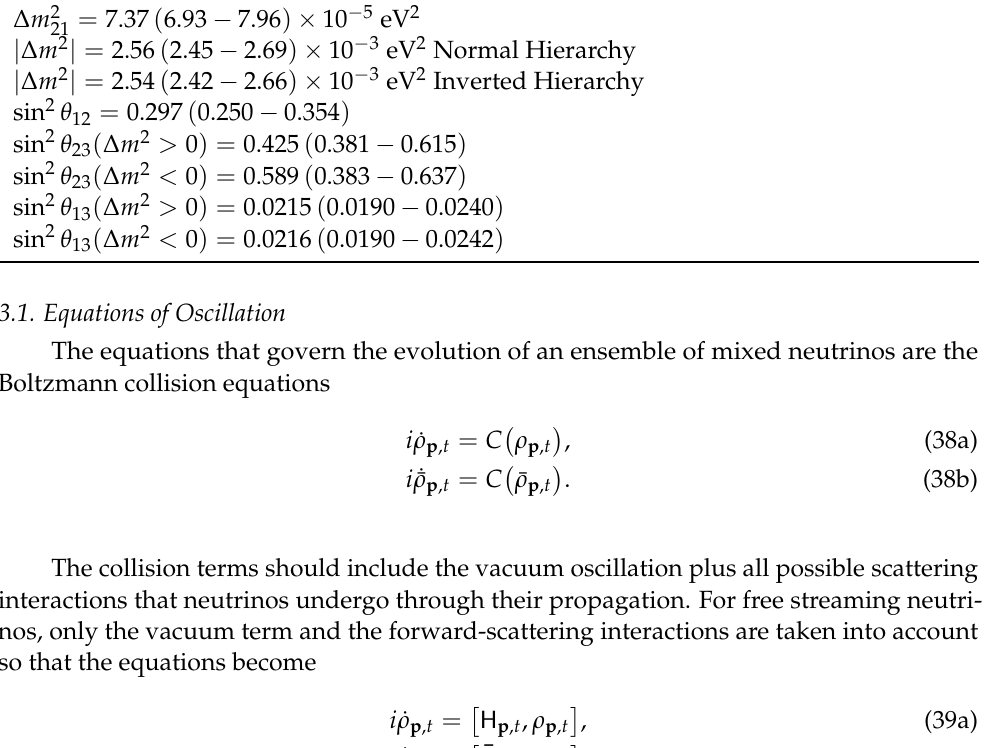
(cid:1) − (cid:0) m 2 + m 2 /2 and 3 2 1